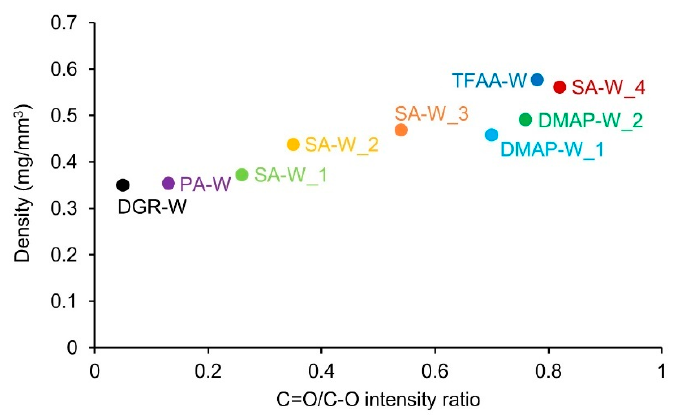
Figure 4. Ratio of the IR peak intensity derived from the C=O groups to that of C–O stretching vibrations (C=O/C–O intensity ratio), showing its dependence on the ratio of the IR peak intensity derived from the OH groups to that of C–O stretching vibrations (OH/C–O intensity ratio).